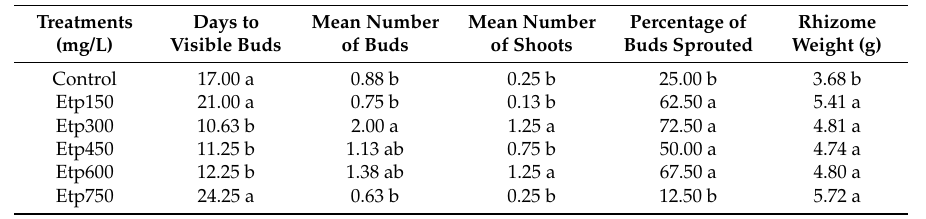
Table 3. The effect of different concentrations of ethephon on the number of days to visible buds, mean number of buds, mean number of shoots, percentage of buds sprouted, and rhizome weight of Z. zerumbet